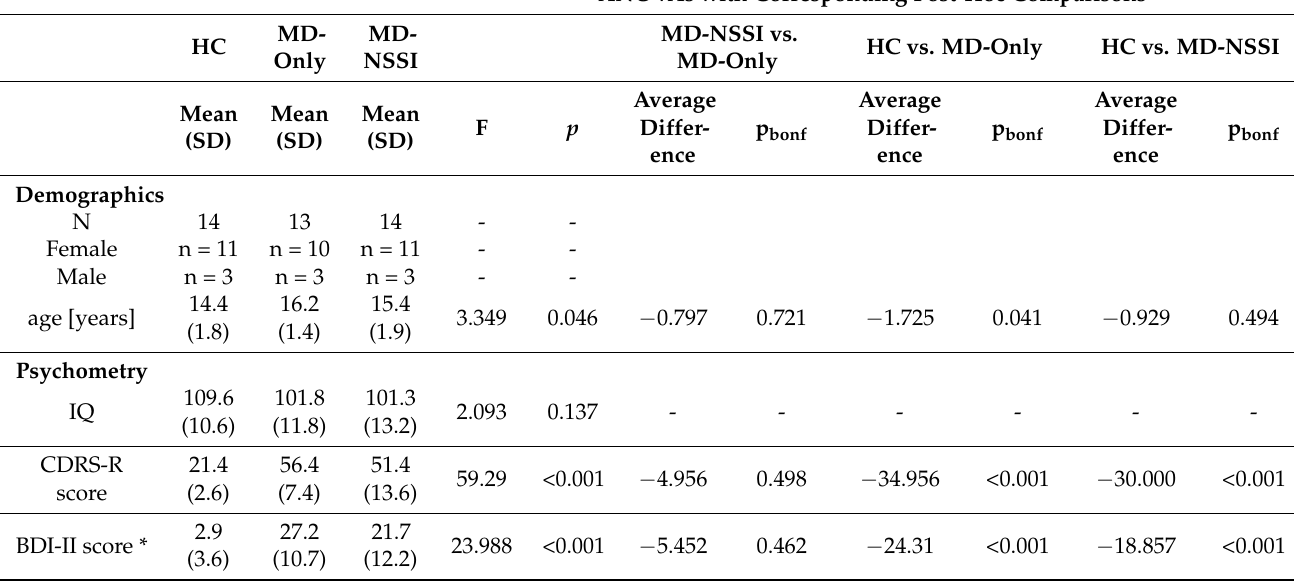
Table 1. Socio-demographic and questionnaire data in healthy controls (HC), adolescents with major depression (MD-only), and depressed adolescents with comorbid non-suicidal self-injury (MD-NSSI). Group differences were calculated with ANOVAs, followed by Bonferroni-corrected post-hoc comparisons at an alpha level of p ≤